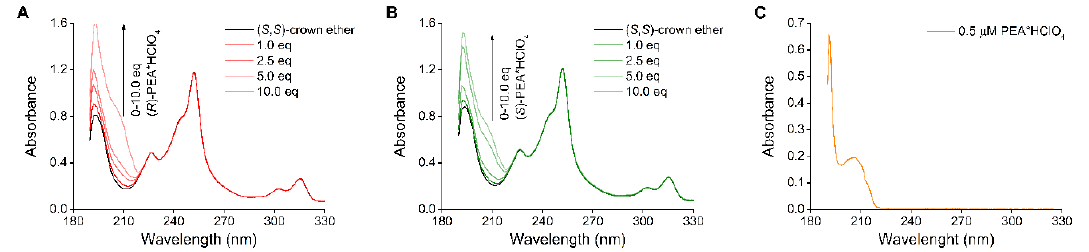
Figure 6. The absorption spectra of crown ether ( S , S )- 1 in the presence of PEA-salts ( R )- 22 and ( S )- 22 ( A , B ) and the absorption spectrum of PEA ( 22 ) as a background signal ( C ).